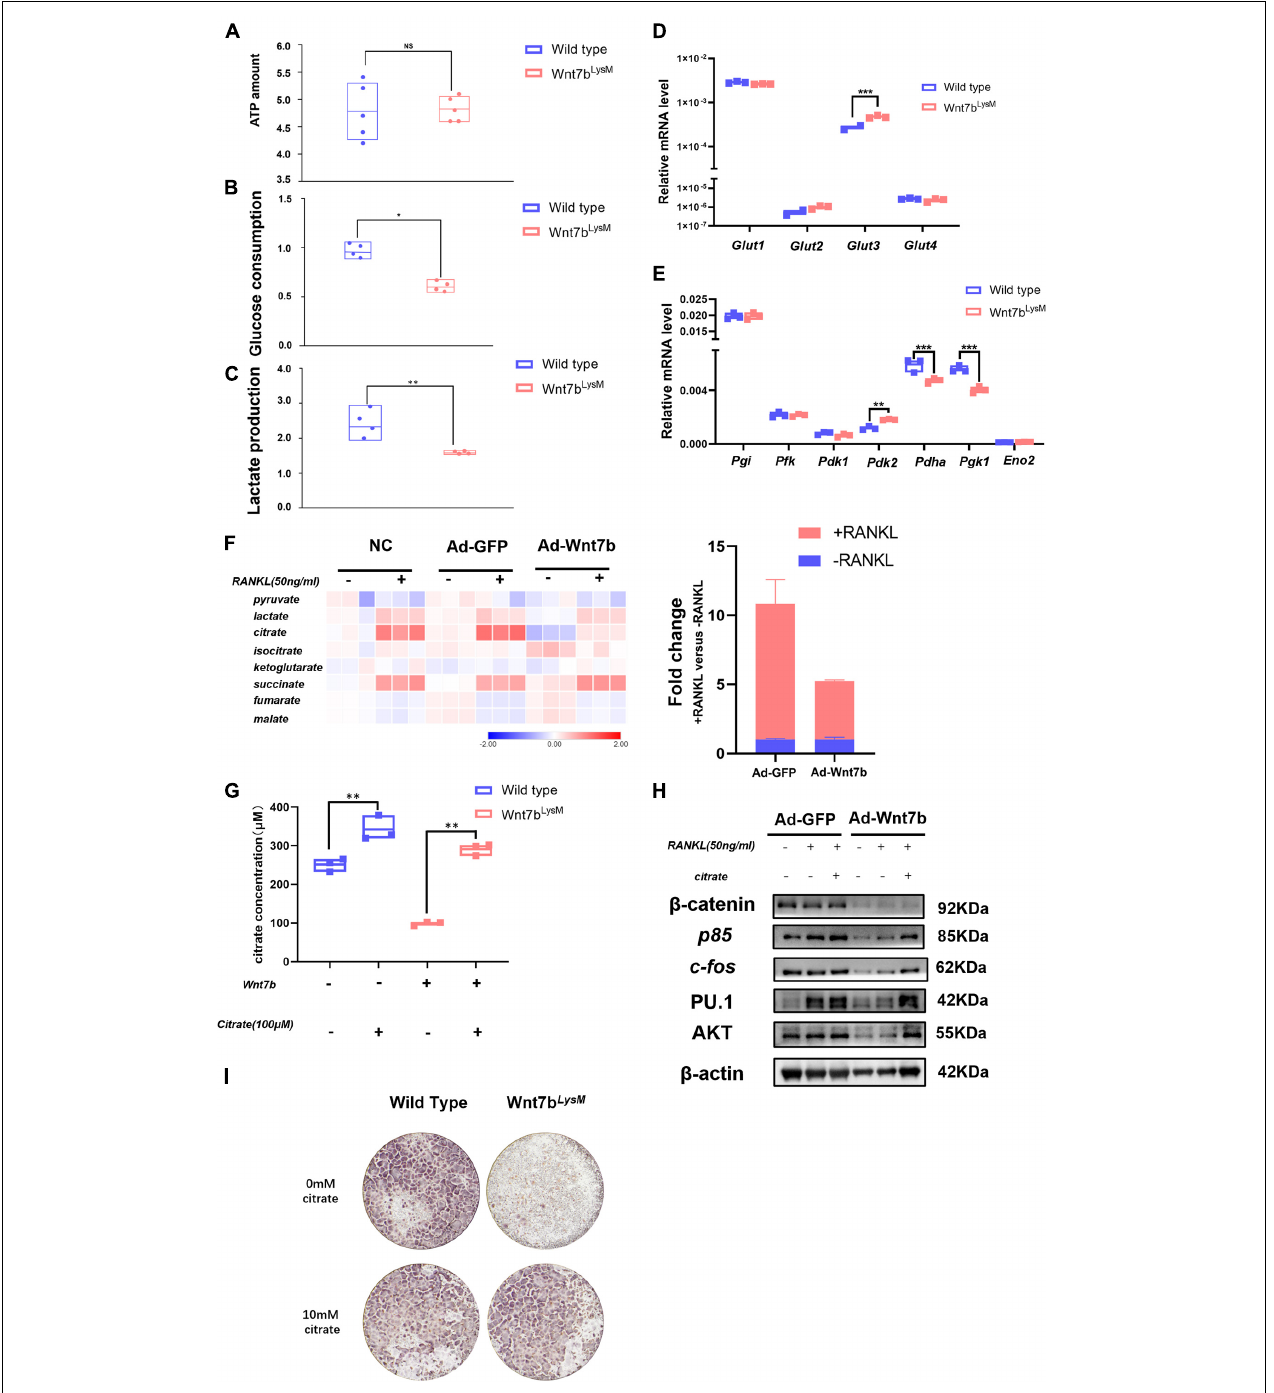
FIGURE 5 | Wnt7b rewires glucose metabolic process in BMMs through regulating AKT degradation. (A–C) Total ATP amount, glucose consumption, and lactate production of Raw264.7 infected with adeno-GFP or adeno-Wnt7b were determined. (D,E) The expression levels of genes of Glut family ( Glut1 , Glut2 , Glut3 , Glut4 ) and glycolysis-related enzymes were analyzed by real-time PCR in primary BMMs. (F) Metabolic profile of intermediates in TCA cycle in Raw264.7 cells infected with adeno-GFP or adeno-Wnt7b in the presence or absence of RANKL. The fold changes of citrate are shown to the right. (G) Intracellular citrate amount in Raw264.7 cells after adeno-GFP or adeno-wnt7b transfection in the presence or absence of exogenous citrate. (H) Raw264.7 cells after adeno-GFP or adeno-Wnt7b transfection were induced with RANKL plus citrate for 1 day. Western blot was used to determine the protein levels of β -catenin, p85, AKT, c-fos and P.U 1. (I) TRAP staining was used to identify TRAP-positive multinucleated cells. BMMs isolated from WT or Wnt7b LysM mice were induced with M-CSF and RANKL for 5 days in addition with or without 10 mM citrate; then, TRAP staining was performed as described. Each dot represented one sample. NS: not significant; * p < 0.05; ** p < 0.01; *** p <